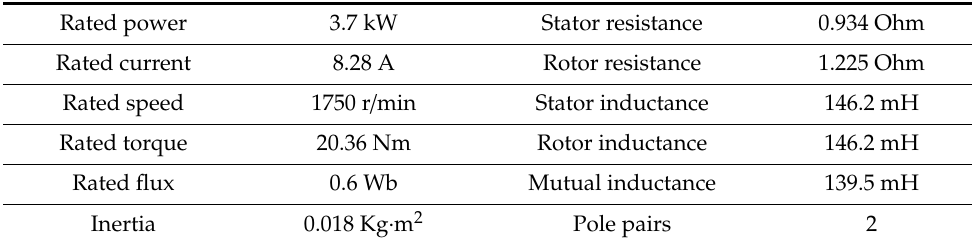
Table 3. Induction motor